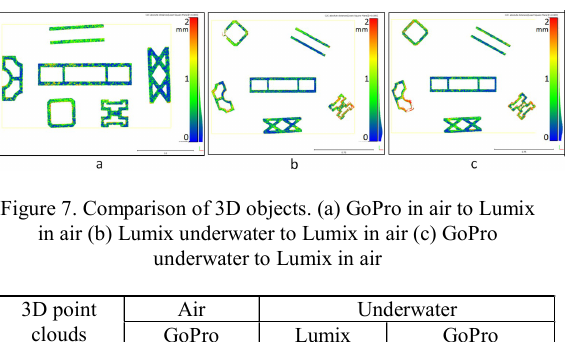
Figure 6. 3D point clouds of objects (a-e are cinder blocks) extracted from the 3D scene generated by using the Lumix camera system in air. The 3D point cloud of each reference object was compared to its counterpart in other 3D scenes respectively. The comparison results are as shown in Figure 7 and the RMSEs are shown in Table 5.